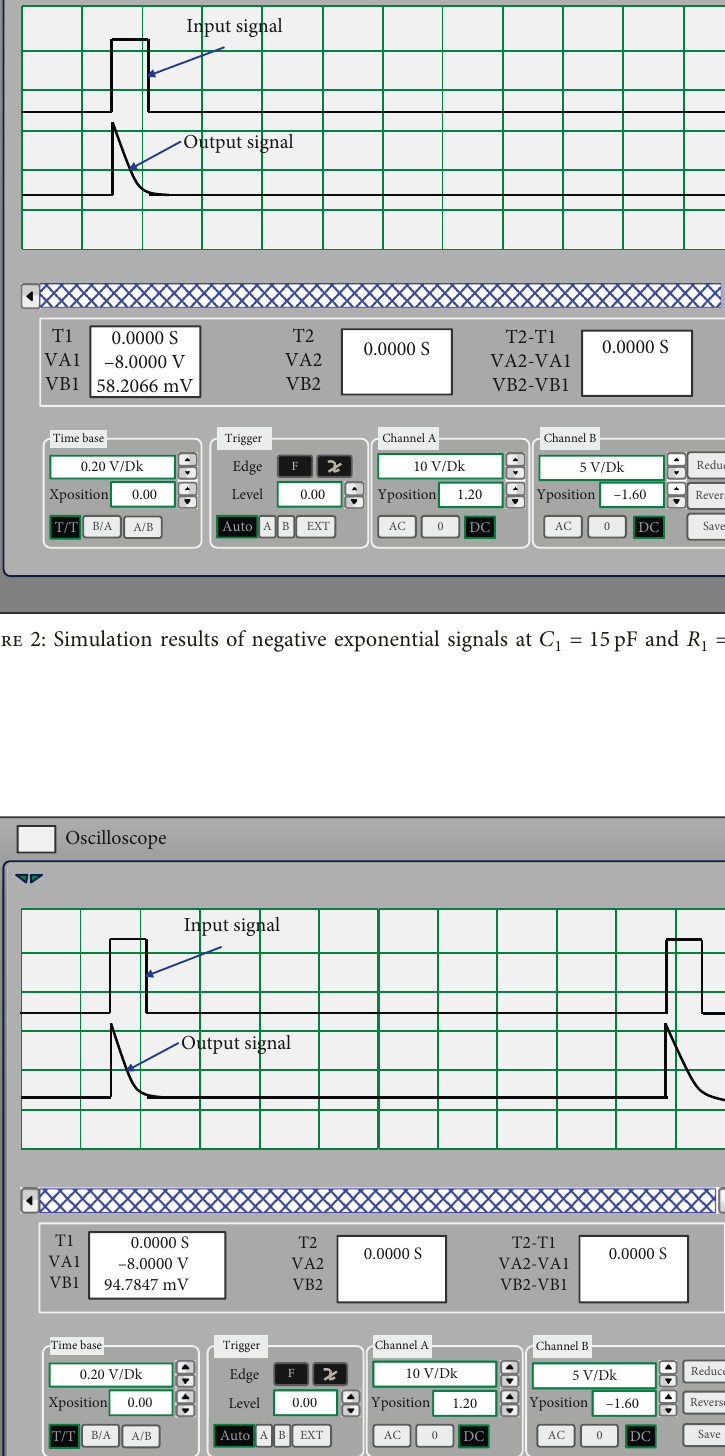
� 30pF and R � 20k Ω 1 1